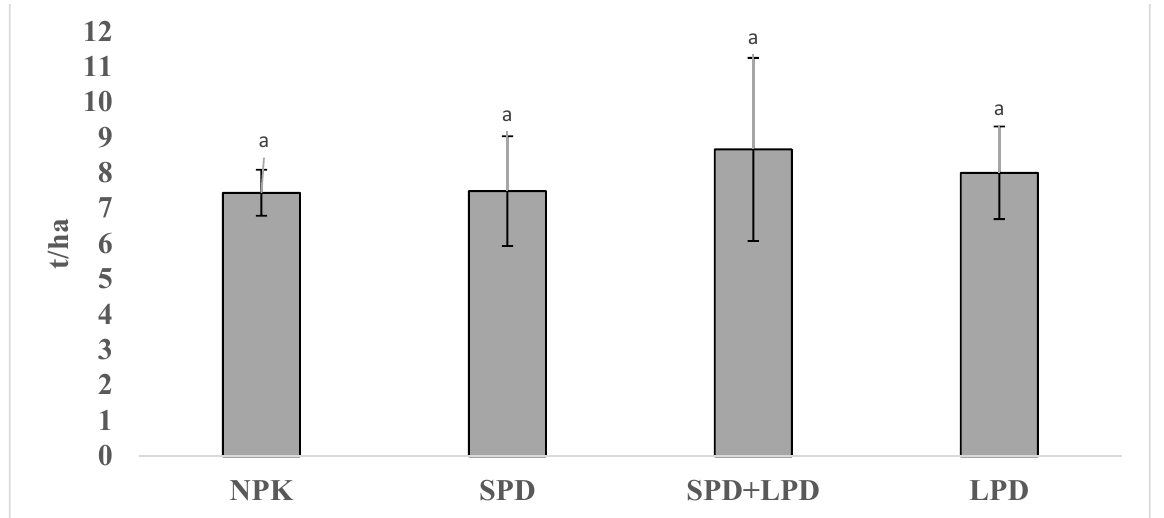
Figure 1. Average dry biomass yield of cannabis with individual variants.